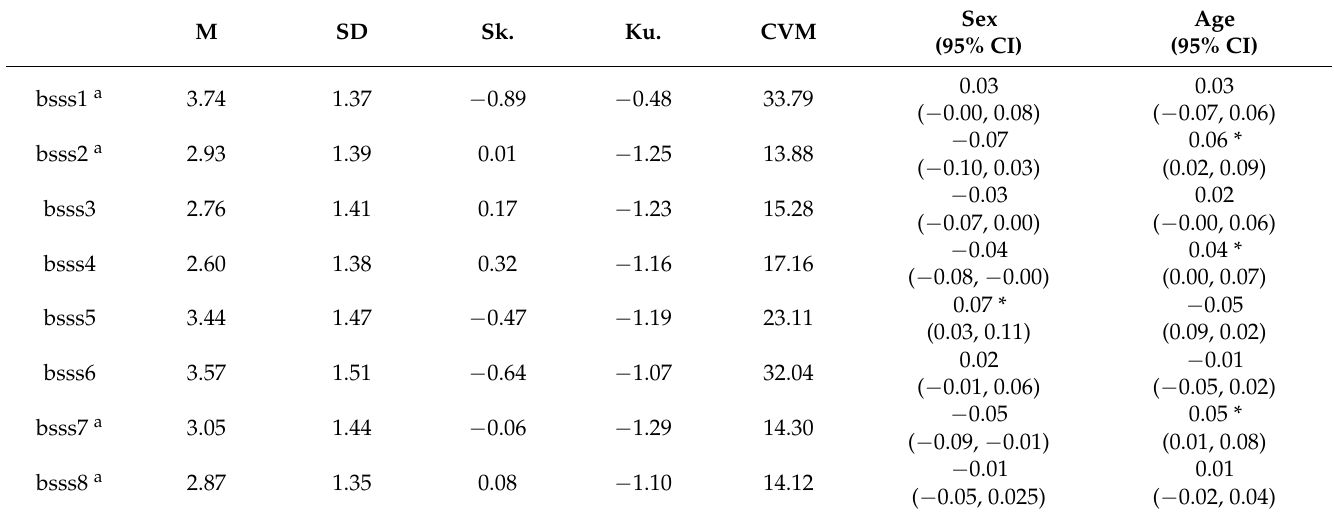
Table 2. Results of the univariate and correlation analyses on the BSSS